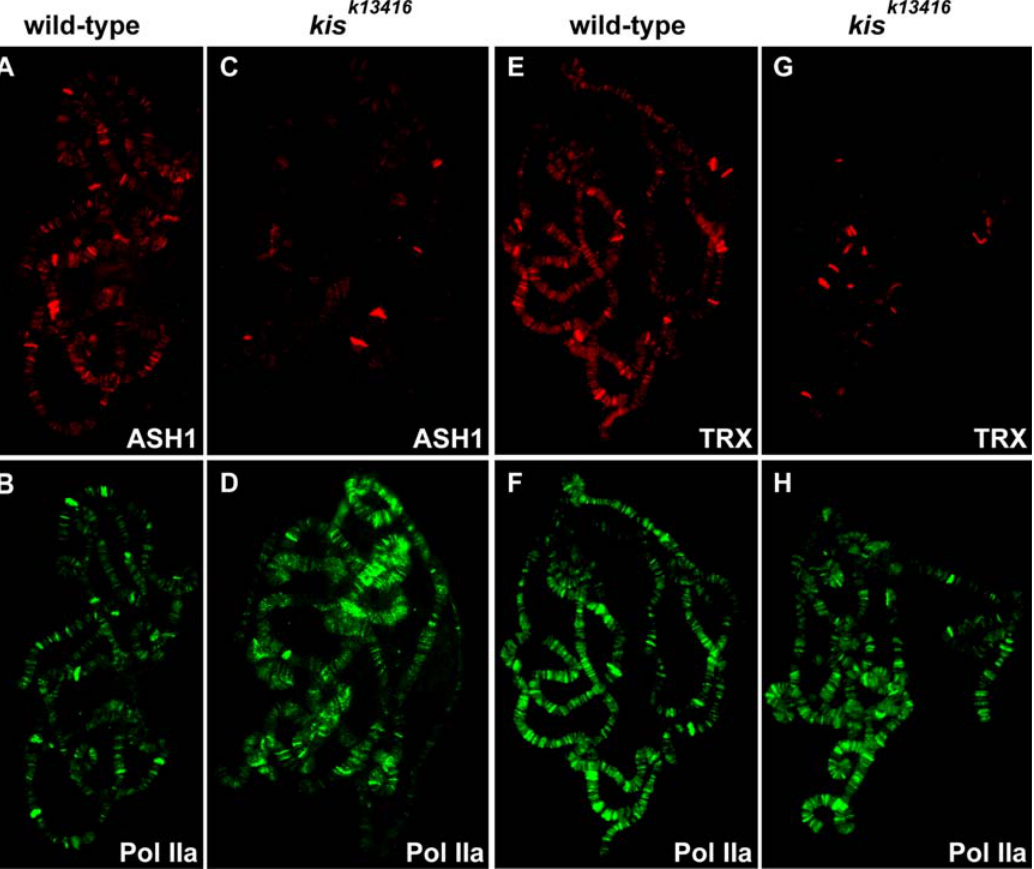
Figure 6. KIS-L is required for the association of ASH1 and TRX with chromatin. The distribution of ASH1 (A, C, red) and TRX (E, G, red) on salivary gland polytene chromosomes isolated from wild-type and kis k13416 larvae were detected by indirect immunofluorescence microscopy. The chromosomes were also stained with an antibody against Pol IIa (B, D, F, H, green) as an internal control. The loss of KIS-L function dramatically reduces the levels of ASH1 and TRX, but not Pol IIa, associated with polytene chromosomes.